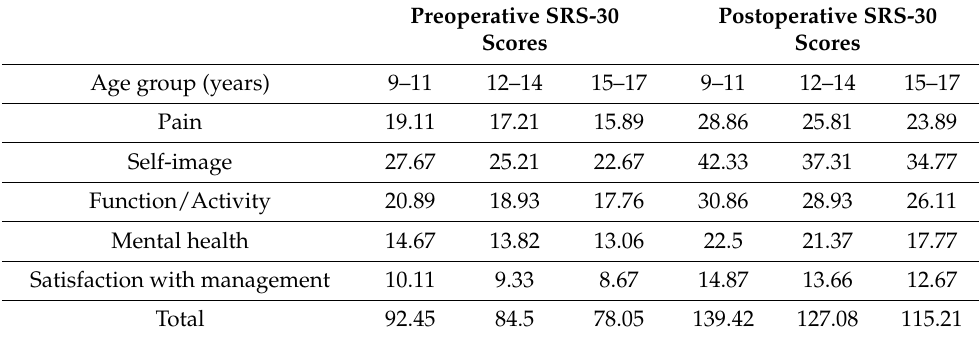
Table 4. Mean scores of SRS-30 questionnaire by age groups before and after the surgery.